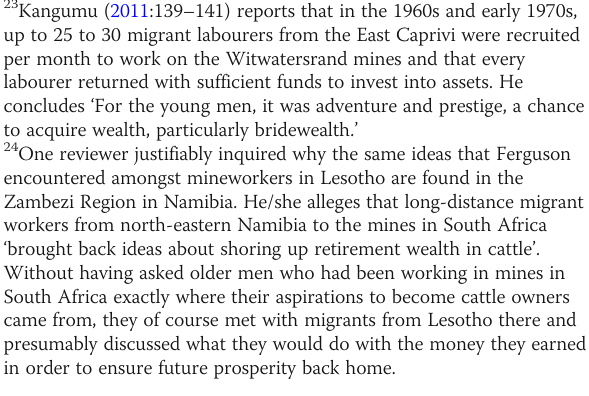
Samduno Relation to head of household or owner of the enclosure Household head and owner of the